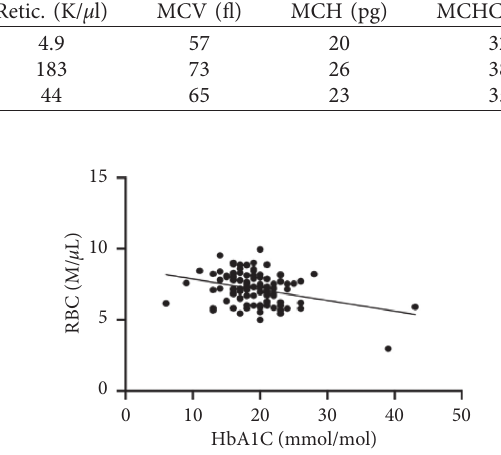
Figure 1: Relation between fructosamine and HbA1c ( r � 0.175; p < 0 . 0001).